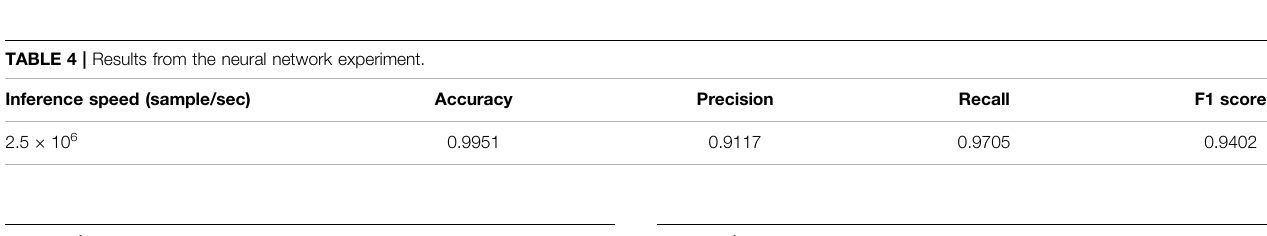
TABLE 5 | Results from different experiments using Random Forest Classi fi er and ad hoc features.